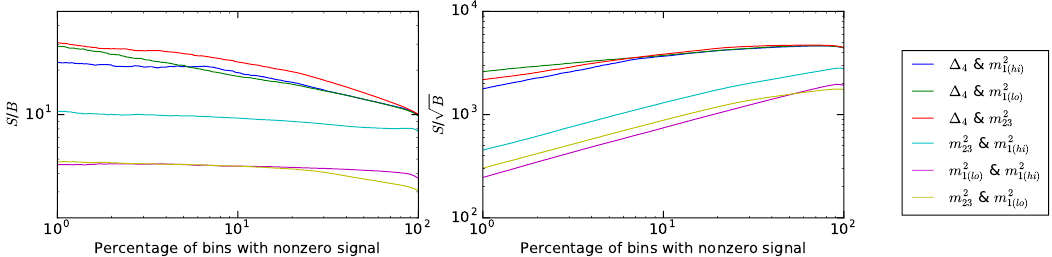
Figure 8 . Performance curves for pairs of variables among (cid:1) 4 and the invariant mass variables, using the S = B (left panel) and S = p B (right panel) metrics, taking (cid:12)nite energy resolution and combinatoric e(cid:11)ects into